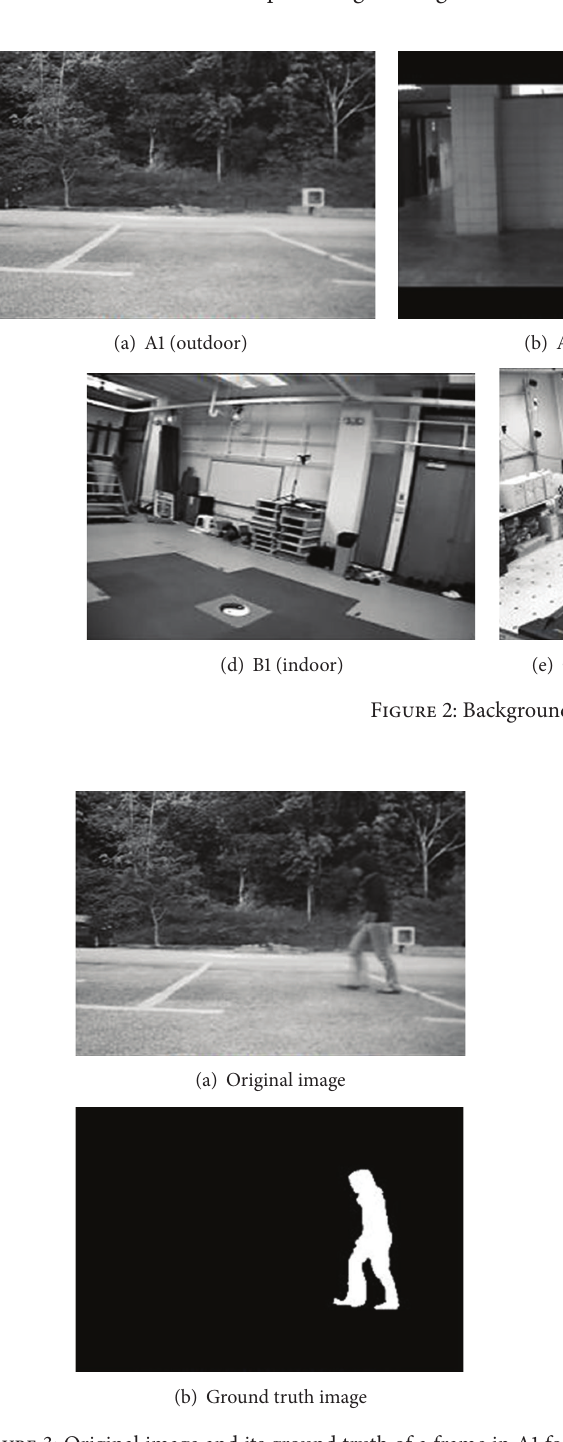
Figure 3: Original image and its ground truth of a frame in A1 for an outdoor